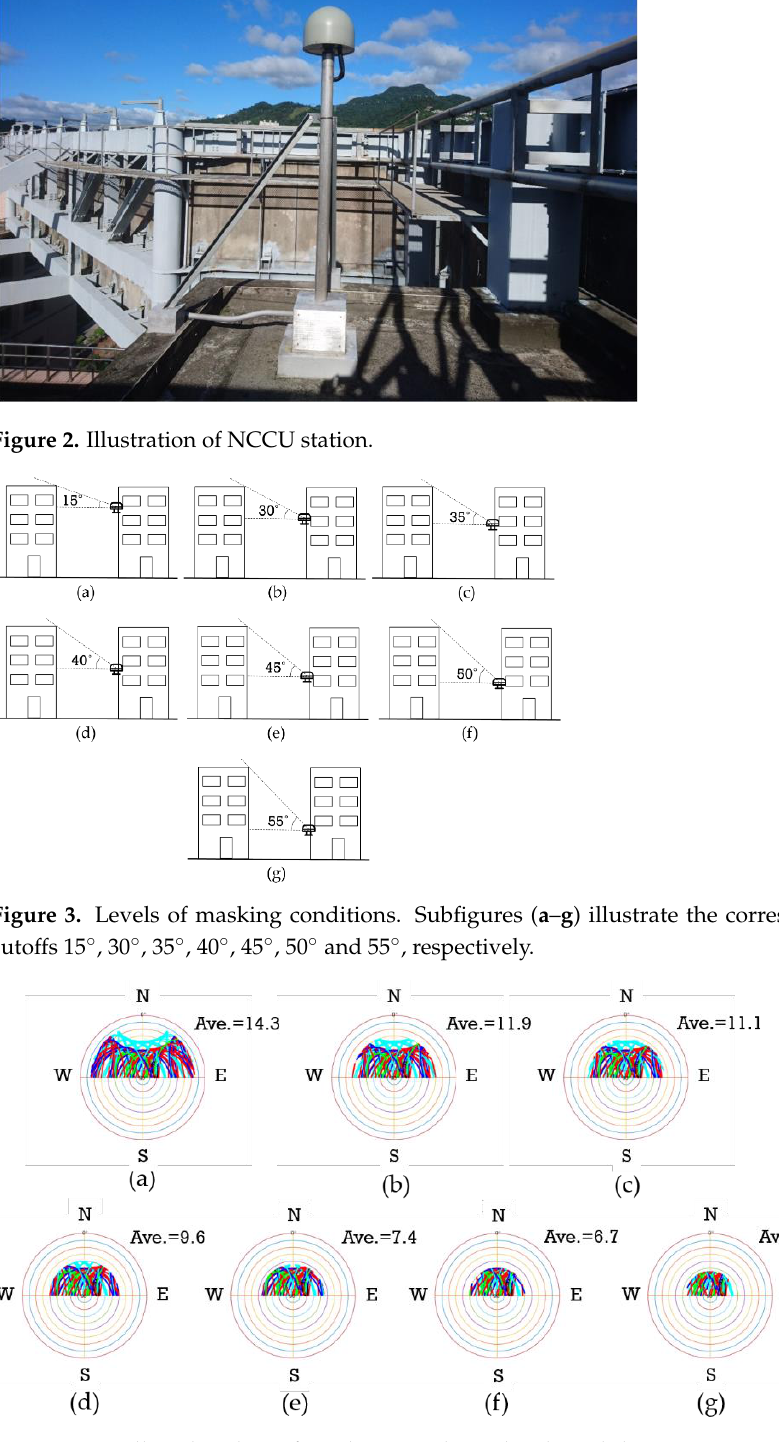
Figure 4. Satellite sky plots of masking condition levels and the average number of satellites on 1 August 2019. The blue, red, cyan, green and black dots refer to GPS, Galileo, GLONASS, BDS and QZSS satellites, respectively. Subfigures ( a – g ) illustrate the elevation cutoffs 15°, 30°, 35°, 40°, 45°, 50° and 55°, respectively. The azimuth cutoff angle is from 90° to 270°.